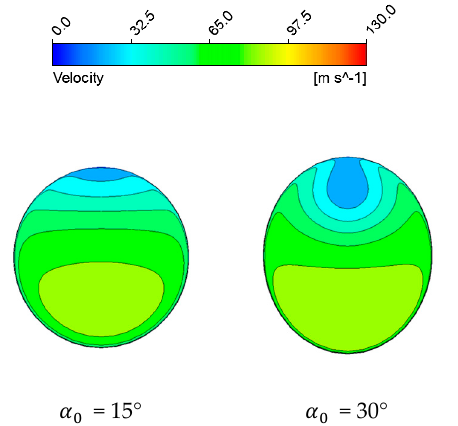
Figure 21. Contours of the velocity at the outlet under 0 r/min (15° and 30°).